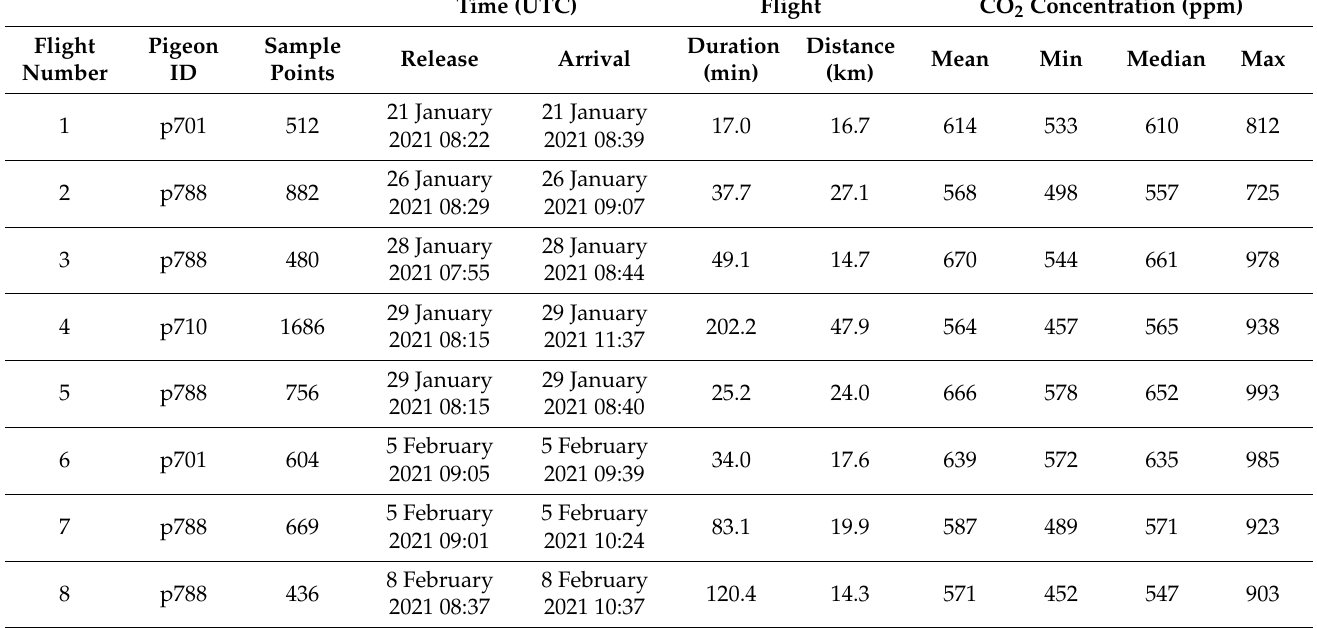
Table A1. List of pigeon releases, including departure and loft arrival times, flight duration, and track length, with a summary of CO 2 values